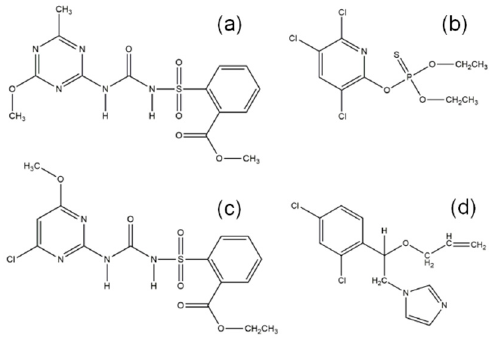
Figure 1. Molecular representation of the pesticides and herbicides used in this work: MSM (metsulfuron) ( a ), CLP (chlorpyrifos) ( b ), CLM (chlorimuron) ( c ) IMZ (imazalil) ( d ).